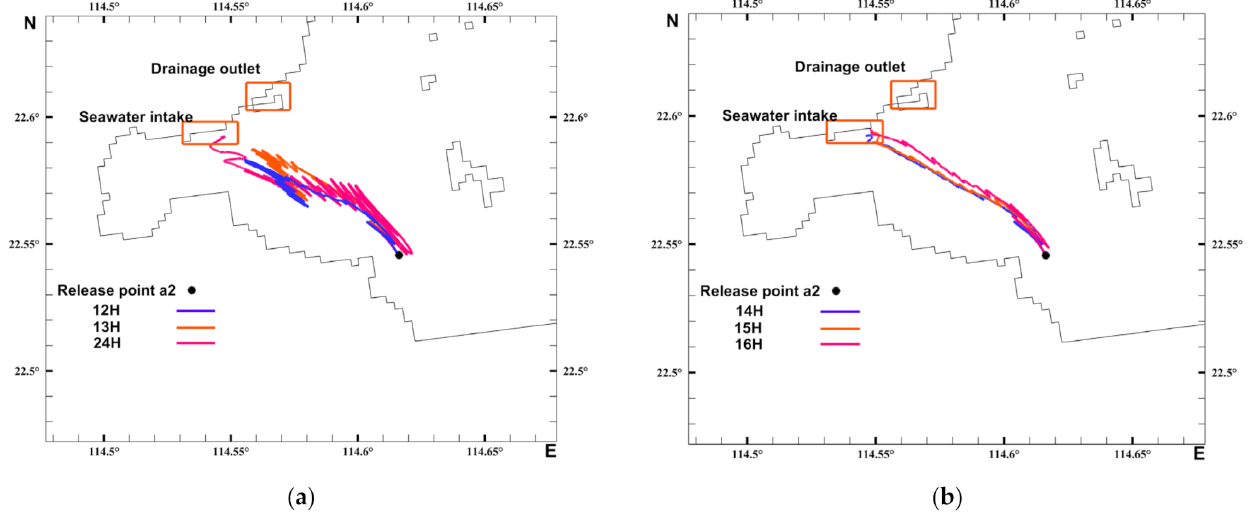
Figure 10. Invasion paths of Acetes with different night migration time: ( a ) 12 h, 13 h, 24 h; ( b ) 14 h, 15 h, and 16 h of night-migration times.